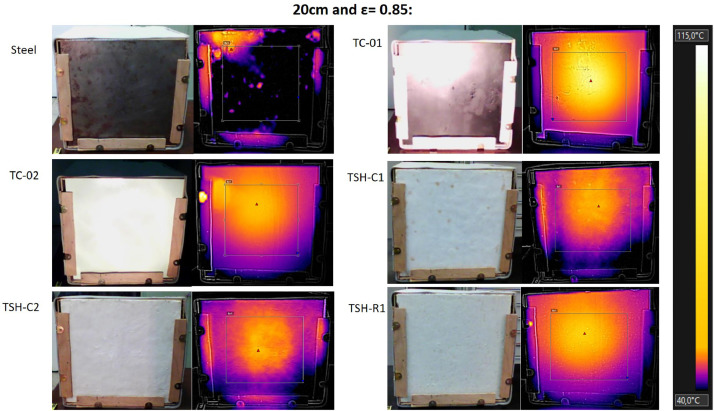
20 cm/no airflow.